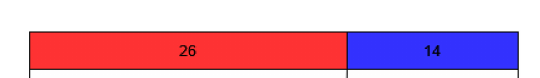
FIGURE4 An example of how output values of 0 and 1 are combined to create a position on the regression scale. As described in Equation (7) the output value for the real part of the scale (red) is divided by the total of the real and inverted (blue) outputs to create the position on the regression scale, in this case 26 = 0.65. This value is then scaled to the full range of 26 + 14 regression values possible in the task to produce the estimated regression value of the